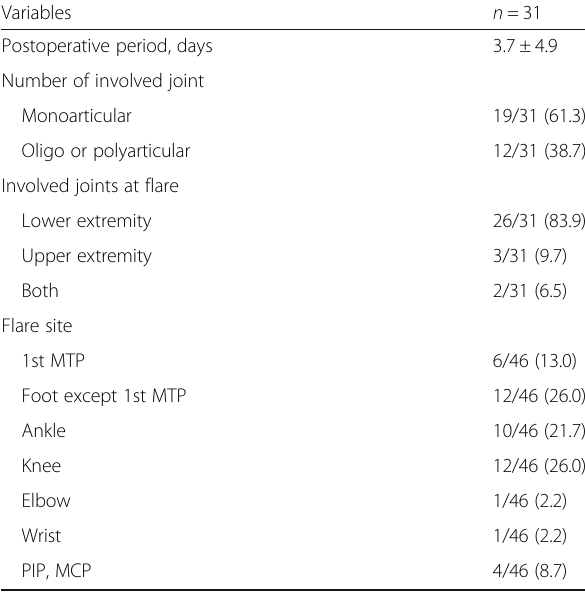
Table 2 Clinical characteristics of patients with gout flare during postsurgical